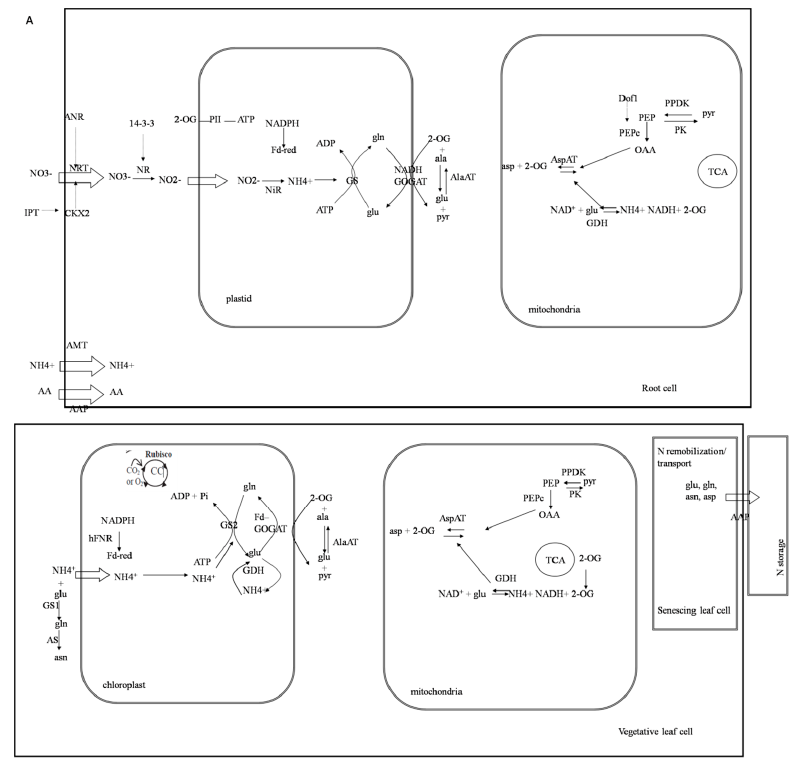
Figure 8. Cont. Figure 8.